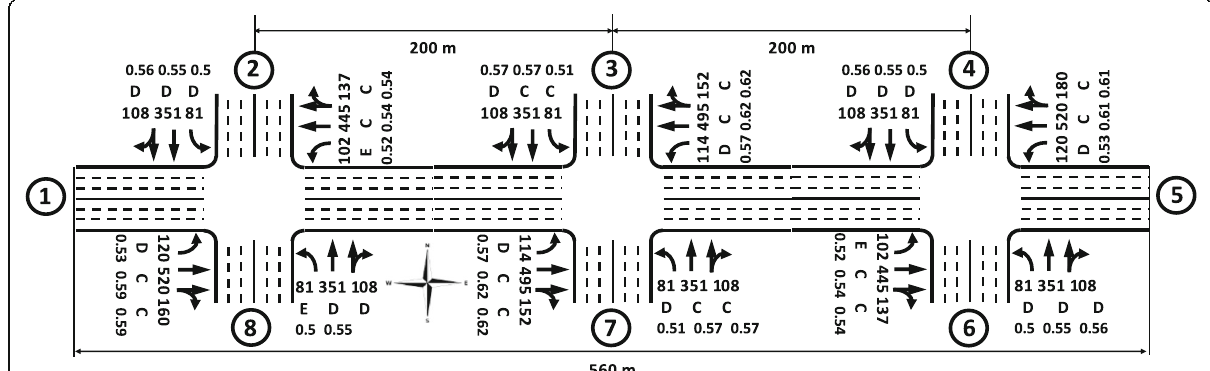
Fig. 4 Geometric and traffic characteristics of the test network